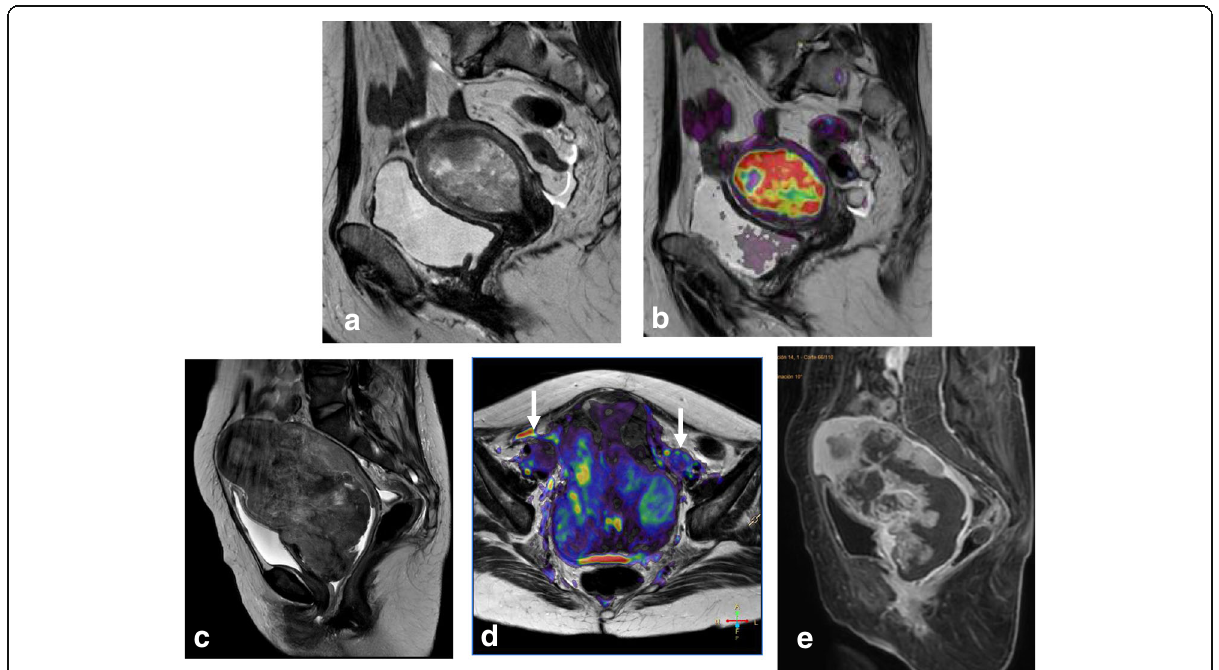
Fig. 11 Endometrial-based tumor visualized with sagittal T2WI ( a ) and sagittal T2WI+DWI ( b ) was found to be a carcinosarcoma mimicking endometrial carcinoma. c – e In another patient, an endometrial stromal sarcoma mimicking cervical cancer is visualized by sagittal T2WI ( c ), axial T2WI+DWI ( d ), and DCE ( e ), revealing a cervical-centered mass with parametrial invasion and adenopathies (arrows in d